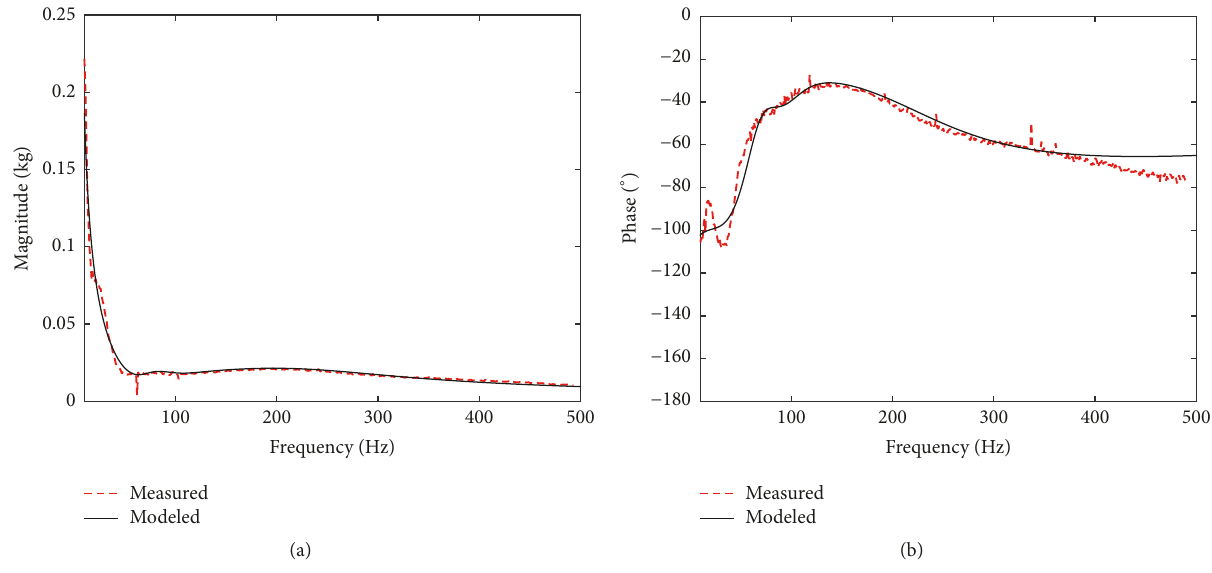
Figure 8: Comparison of the two-phalanx measurement and 2-Phalanx model apparent mass: (a) magnitude; (b) phase.